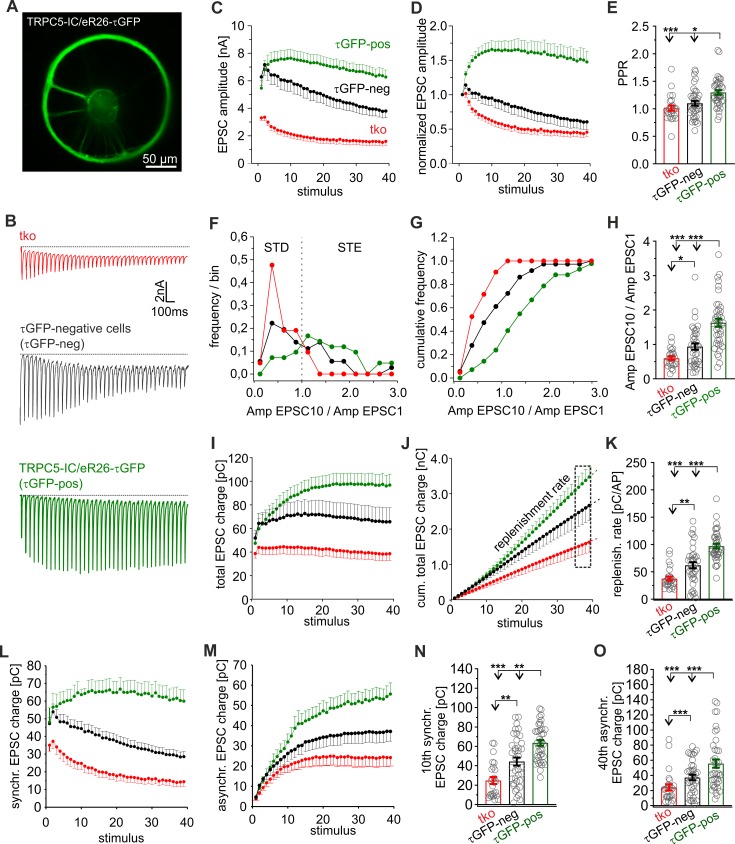
Endogenous TRPC5 channels promote STE of synaptic signaling.(A) Exemplary epifluorescence image of an autaptic TRPC5-IC/eR26-τGFP neuron. (B) Sample recordings from tko, τGFP-negative and τGFP-positive neurons upon 20-Hz HFS. (C–E) τGFP-positive cells show a strong STE of synaptic signaling and an increased PPR (panel E, EPSC2/EPSC1) when compared with tko or τGFP-negative neurons (τGFP-positive versus tko p = 0.00005; τGFP-positive versus τGFP-negative p = 0.003). (F and G) Frequency and cumulative frequency distribution of the AmpEPSC10/AmpEPSC1 ratios for tko (red), τGFP-negative (black), and τGFP-positive neurons (green). (H) The AmpEPSC10/AmpEPSC1 ratio is higher in τGFP-negative cells than in tko neurons and even further increased in τGFP-positive cells (τGFP positive versus tko p = 7.892264 × 10−9; τGFP positive versus τGFP negative p = 0.0009; τGFP negative and tko p = 0.02). (I) Time course of total charge during HFS. (J and K) The replenishment rate determined from the cumulative charge plot shown in panel J gradually increases between tko, τGFP-negative, and τGFP-positive neurons (τGFP positive versus tko p = 1.5 × 10−10; τGFP positive versus τGFP-negative p = 0.0001; τGFP negative and tko p = 0.002). (L and M) Time courses of synchronous and asynchronous charge transfer during the stimulus train. (N and O) The 10th EPSC charge and the 40th asynchronous charge are significantly increased in τGFP-negative and -positive neurons (10th charge: τGFP positive versus tko p = 1.7 × 10−8; τGFP positive versus τGFP negative p = 0.003; τGFP negative and tko p = 0.002; 40th charge: τGFP positive versus tko p = 0.00004; τGFP poisitive versus τGFP negative p = 0.004; τGFP negative and tko p = 0.018). Data were collected from tko (n = 25), τGFP-negative (n = 38), and τGFP-positive (n = 40) neurons. *p < 0.05, **p < 0.01, ***p < 0.001, one-way ANOVA on ranks followed by Dunn’s post hoc test; significance was also tested by Mann-Whitney rank sum test for τGFP-negative cells versus tko. Underlying data can be found in S1 Data. Amp, amplitude; AP, action potential; EPSC, evoked postsynaptic current; eR26, ROSA26-floxed-stop; HFS, high-frequency stimulation; IC, internal ribosomal entry site cre recombinase; PPR, paired-pulse ratio; STD, short-term depression; STE, short-term enhancement; tko, triple knockout; TRPC, transient receptor potential canonical; τGFP, τ-green fluorescent protein.